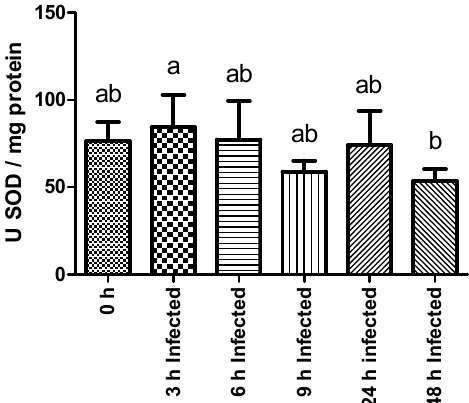
Figure 2. Liver SOD (superoxide dismutase) activity of rainbow trout sampled before (0 h) or 3, 6, 9, 24, and 48 h post-intraperitoneal infection with Y. ruckeri (means ± SD, n = 6). Letters indicate significant differences between the bio-groups ( p ≤ 0.05).